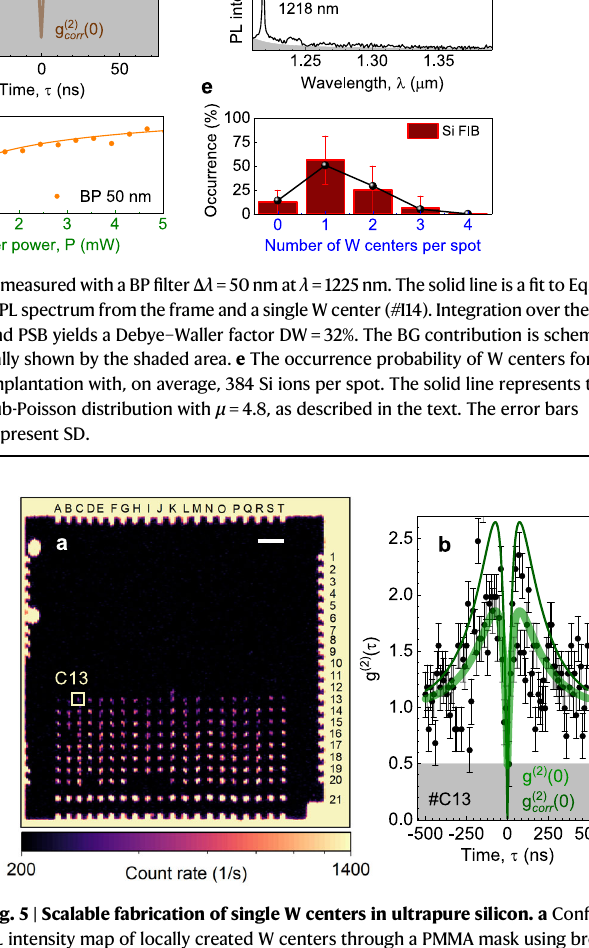
Fig. 5 | Scalable fabrication of single W centers in ultrapure silicon. a Confocal PL intensity map of locally created W centers through a PMMA mask using broad- beam Si implantation. The nominal hole diameter increases from 30nm (row 1) to 400nm(row 20).ThePLiscollected using aBP fi lter Δ λ =50nmat λ =1225nm.No annealing is performed. The scale bar is 20 μ m. b Second-order autocorrelation function g (2) ( τ )obtainedwithnoBGcorrectionfromthespot # C13.Thegreensolid line is a fi t to Eq. (1), yielding g (2) (0)=0.48±0.27. The thin solid line is g ð 2 Þ corr ð τ Þ calculated according to Eq. (2). The error bars represent SD.